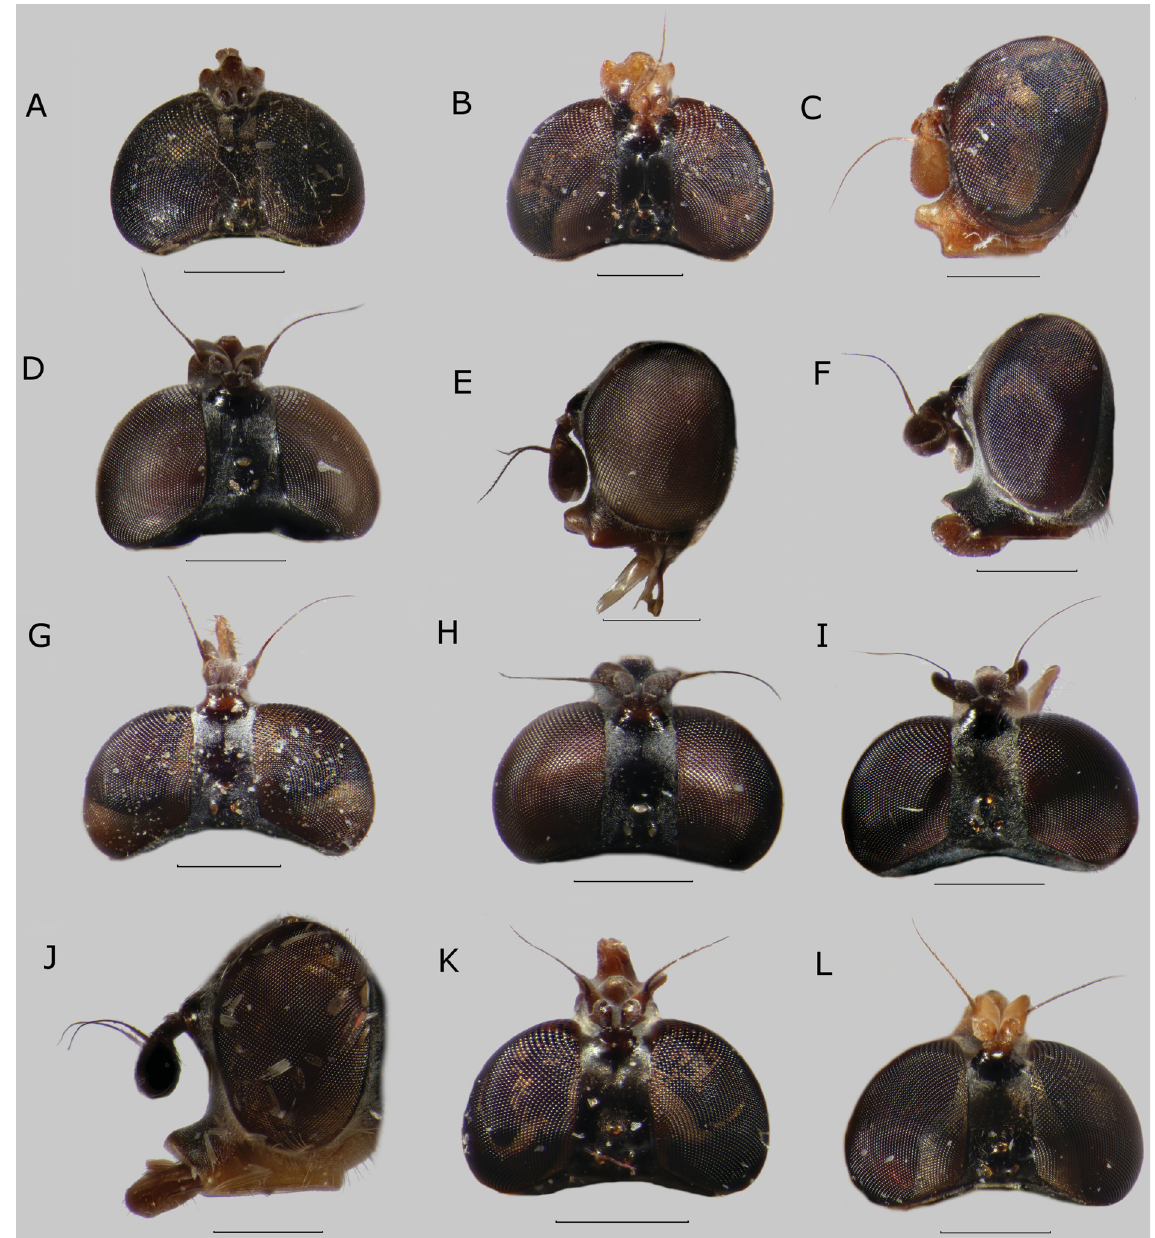
Fig. 88. Head. lateral view (C, E, F, J) and dorsal view (A–B, D, G–I, K–L). A . Sphegina